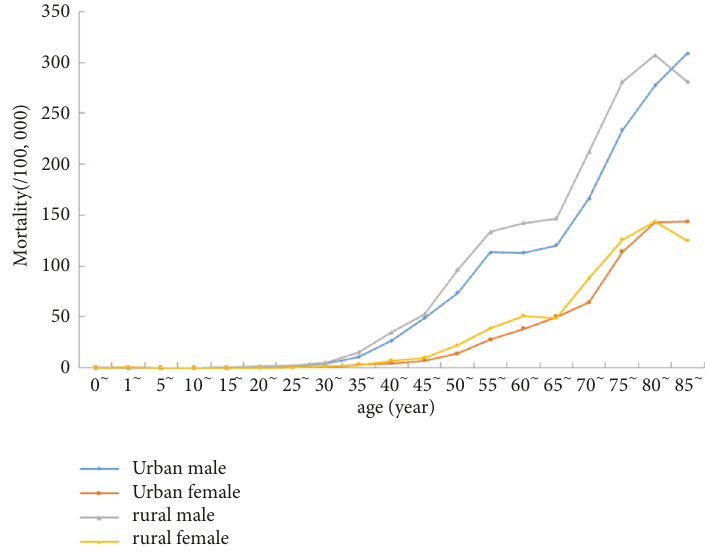
Figure 1: Age-specific incidence rate of liver in Zhejiang urban and rural areas from 2005 to